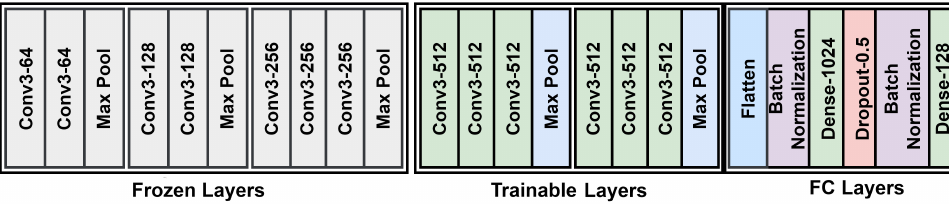
Figure 5. The proposed CNN architecture is based on the VGG16 network. The weights of this net are pre-trained on ImageNet dataset. The fully connected layers are changed in our architecture. The weights of the first three groups are frozen and the weights of the last two groups are trained using the